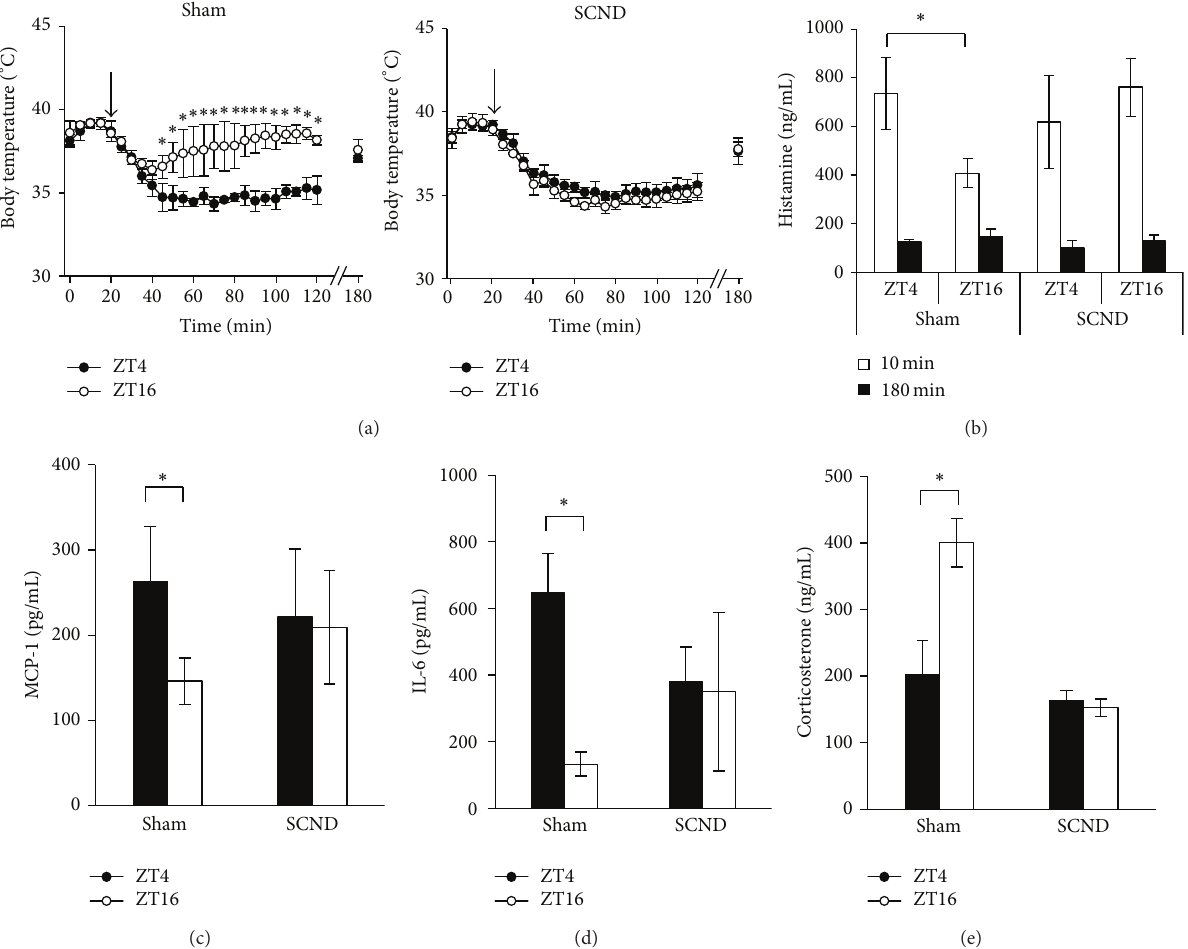
Figure 2: The SCN ablation blunts a time of day-dependent variation in PSA reaction. (a) Changes in rectal temperature over time after the allergen challenge at ZT4 (10:00a.m.) and ZT16 (10:00p.m.) in sham-operated mice (Sham) and mice with disrupted SCN (SCND) (𝑛 = 4) . The arrows indicate the time of antigen challenge (b)–(d). The serum histamine (b), MCP-1 (CCL2) (c), and IL-6 (d) levels following induction of PSA reactions at ZT4 and ZT16 in sham-operated mice or mice with SCN disruption ( 𝑛 = 4 per group). Concentrations of histamine were measured using serum samples collected at 10 and 180 minutes after induction of PSA reaction at ZT4 or ZT10. Concentrations of MCP- 1 and IL-6 were measured using serum samples collected at 180 minutes after induction of PSA reaction at ZT4 or ZT16. (e) The serum corticosterone levels at ZT4 and ZT16 in sham-operated mice and mice with SCN disruption ( 𝑛 = 4 per group). ∗ 𝑃 < 0.05 . Similar results were obtained in at least two independent